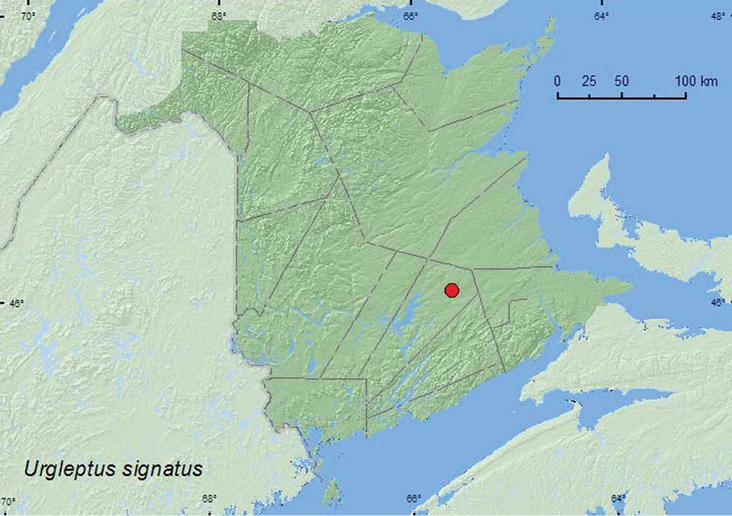
 Collection localities in New Brunswick, Canada of Urgleptus signatus.